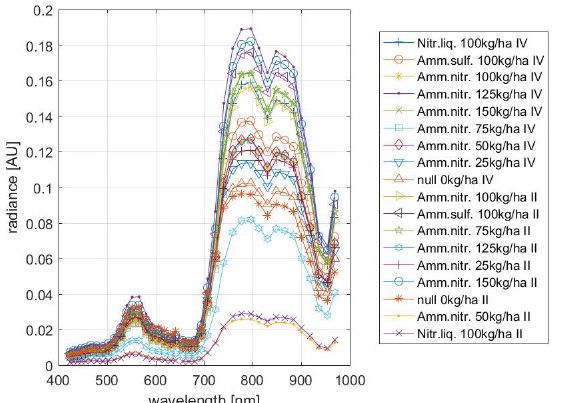
Figure 14 Measured spectral radiances of grass test plots with different Nitrogen fertilizer amounts measured on 1.8.2017 at the Luke. Jokionen grass test field with VIS and NIR Figure 17 During the first test flight the drone was flown hyperspectral cameras. manually over various types of vegetation. Base ortho photo courtesy of National Land Survey of Finland. Altitude 90m above field, typical ground speed varied from